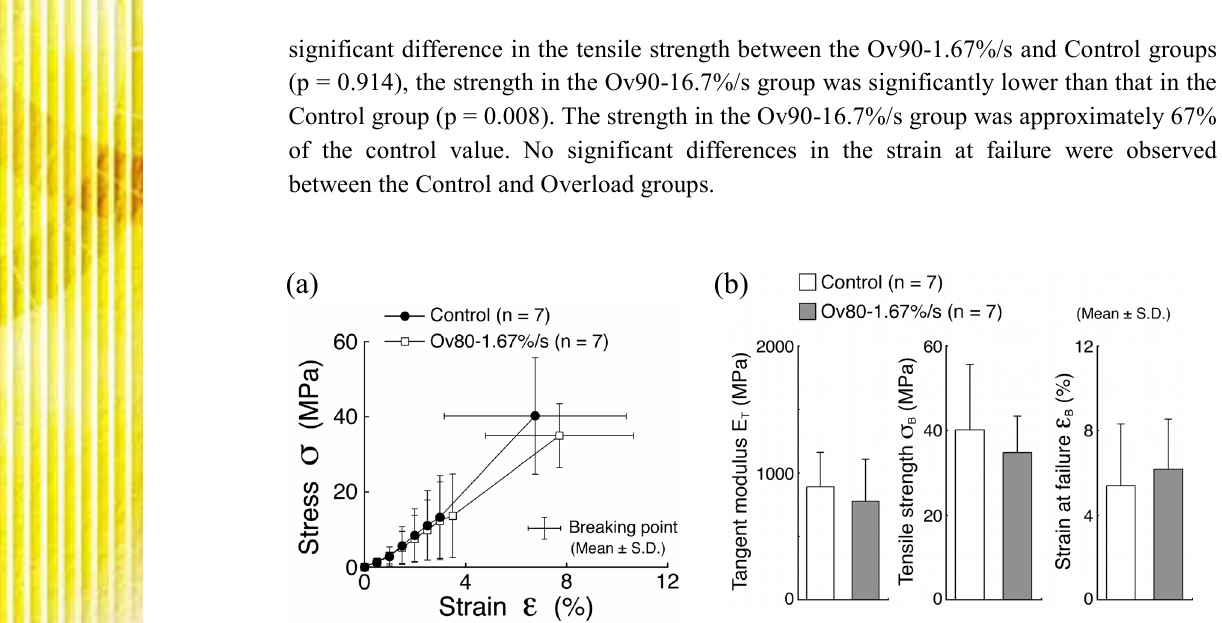
Fig. 3 Stress-strain curves (a) and tensile properties (b) of the control specimens and the specimens overloaded to 80% of the failure stress of the normal tendons at the strain rate of 1.67 %/sec (Ov80-1.67%/s group).